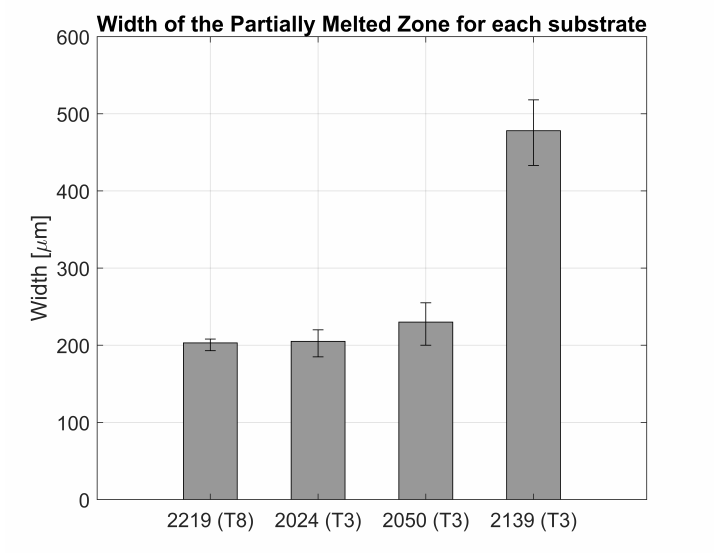
Figure 6. Width of the area affected by liquation depending on the substrate